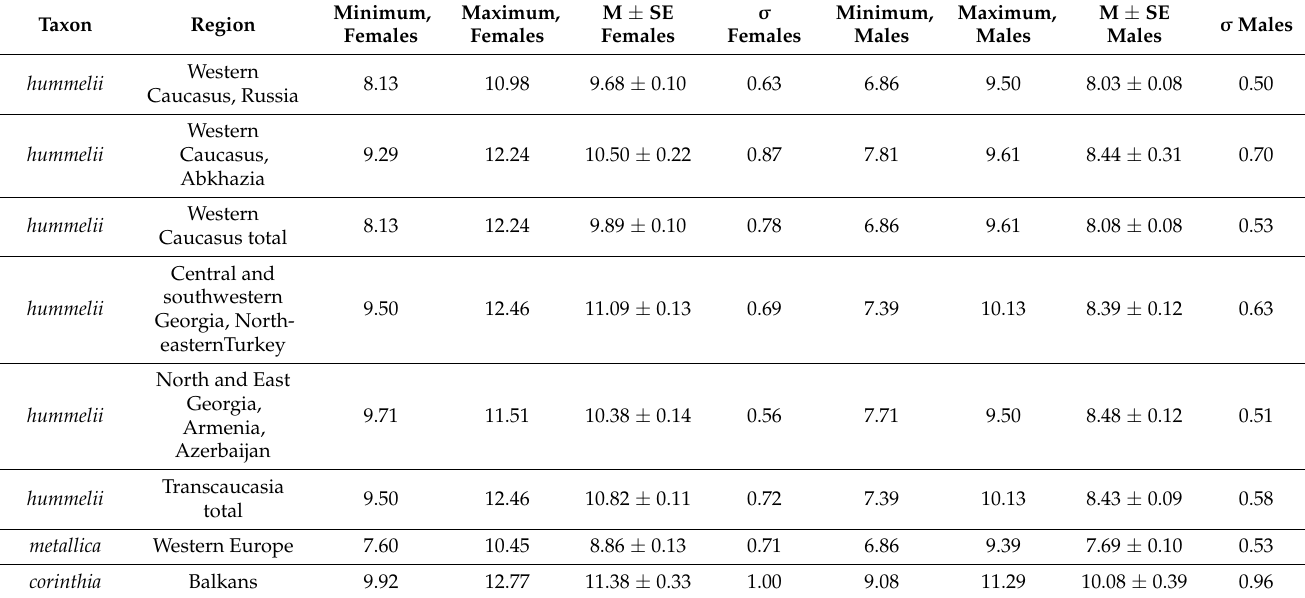
Table 3. Total body length, mm. M—mean value, σ —standard deviations, SE—standard error.